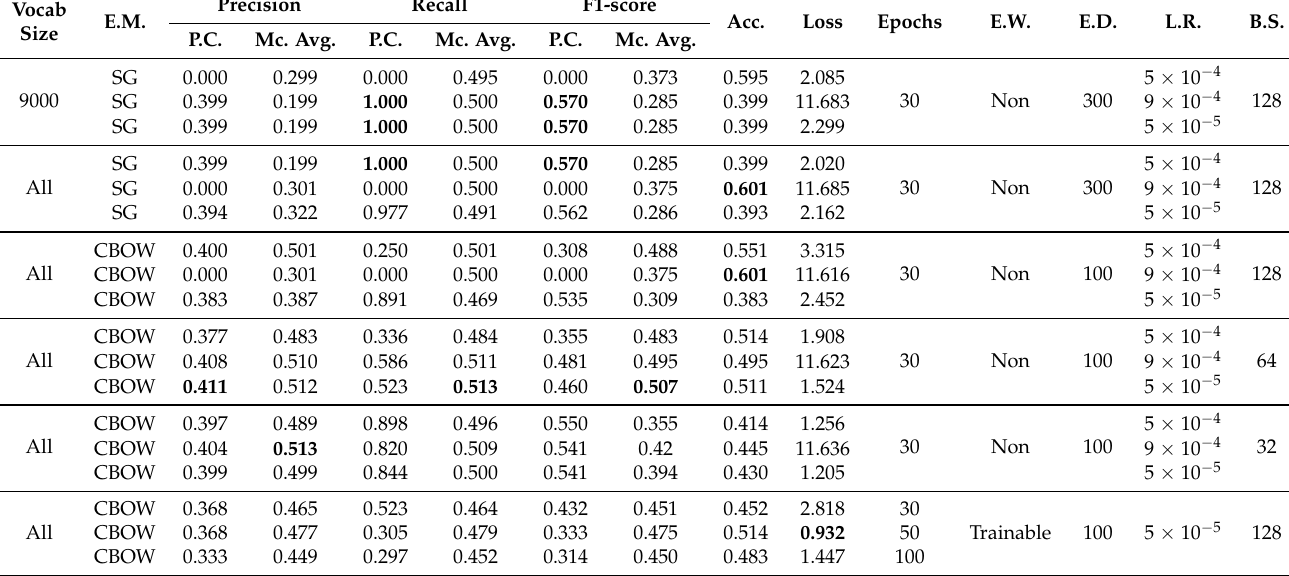
Figure 12 shows the convergence curves of the best models obtained from each approach: the signal-based, the transcript-based, and the hybrid model. The convergence shows the epochs on the x -axis and the accuracy on the y -axis. The convergence is depicted for training (black) and validation (blue), the signal-based is shown for 50 epochs, and the transcript-based/hybrid models plotted over 30 epochs. From the figure it is clear that